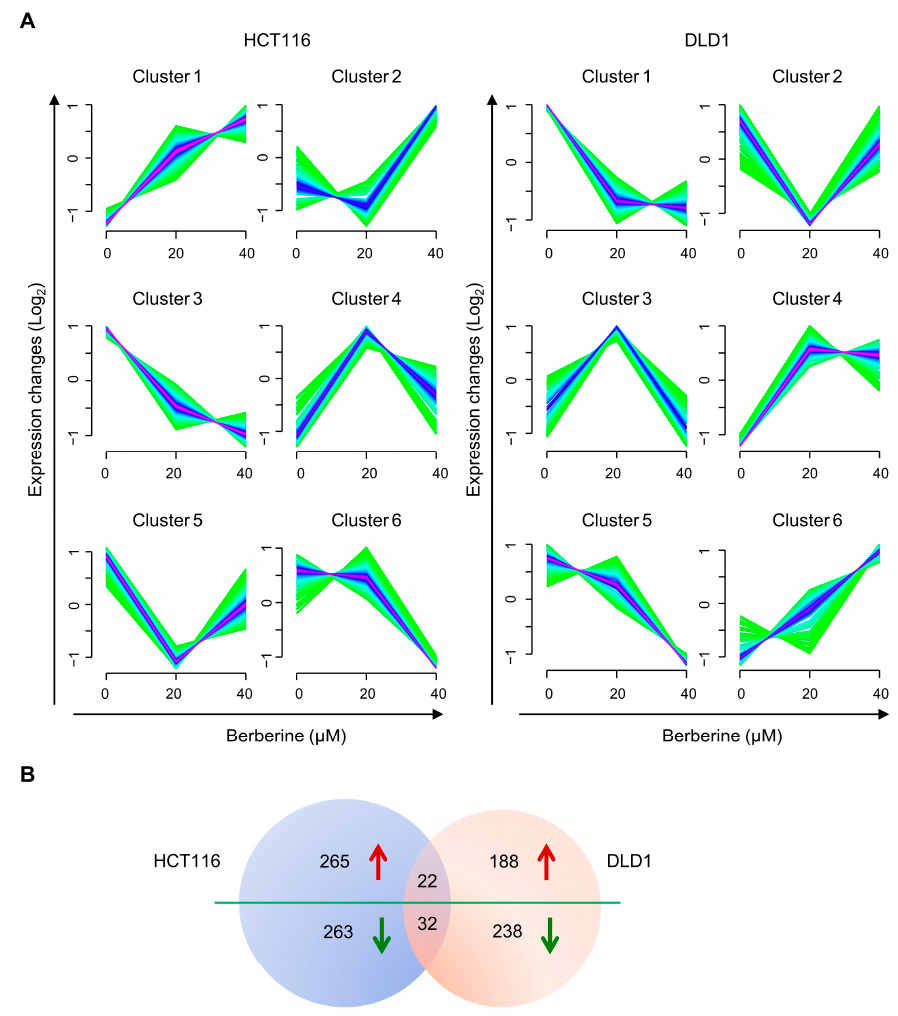
Figure 3. Soft clustering analysis of differently expressed proteins (DEPs) in berberine-treated HCT116 and DLD1 cells. ( A ) Protein expression changes of berberine-treated HCT116 and DLD1 cells in six clusters. The color varying from green to red represents that the degree of protein expressions matching with the patterns of the cluster. ( B ) Venn diagram of DEPs between HCT116 and DLD1 cell lines. Red arrows indicate up-regulated trend and green arrows indicate down- regulated